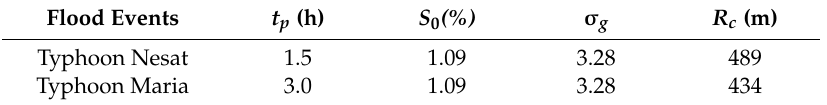
Table 1. Field data collection for bend scour induced by Typhoons Nesat and Maria [21,46]. Flood